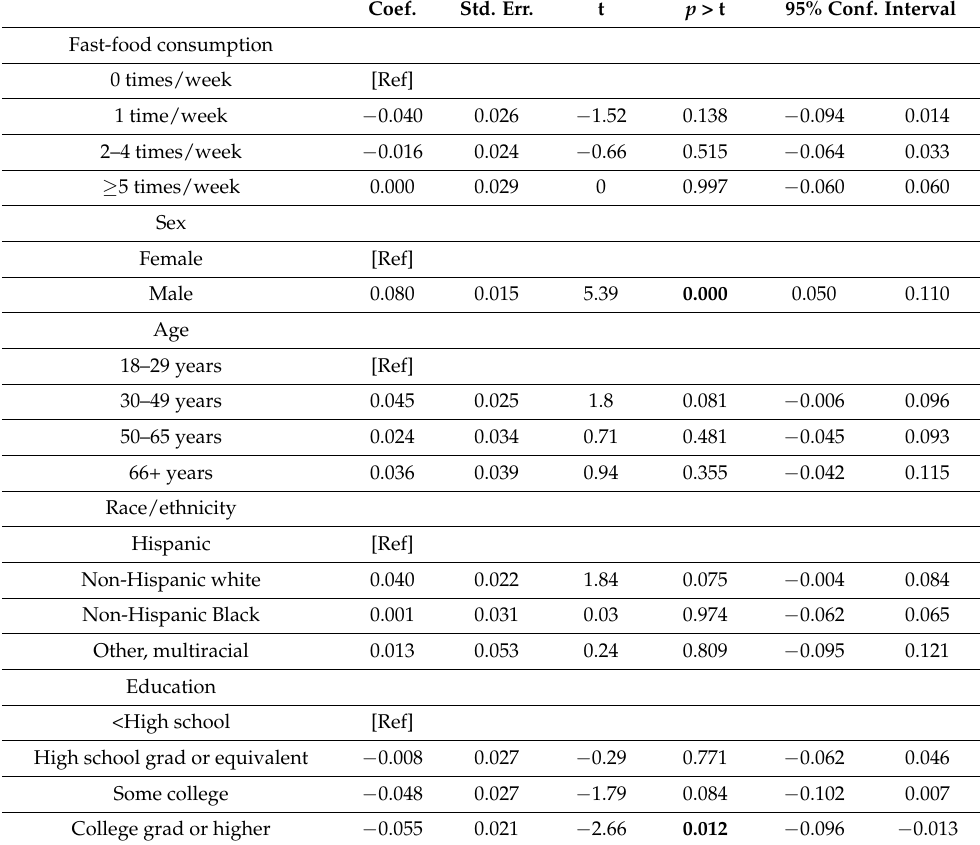
Table A2. Full Model Results for Daily GHGE Per 2000 Kcal by Fast Food Frequency, NHANES